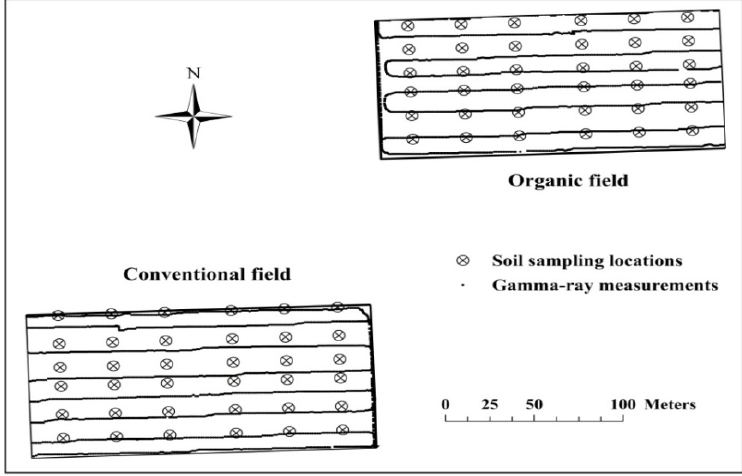
Figure 2. The study fields are shown with soil sampling locations (circles with crosses). The black dots (lines) are gamma-ray measurements measured every second in the